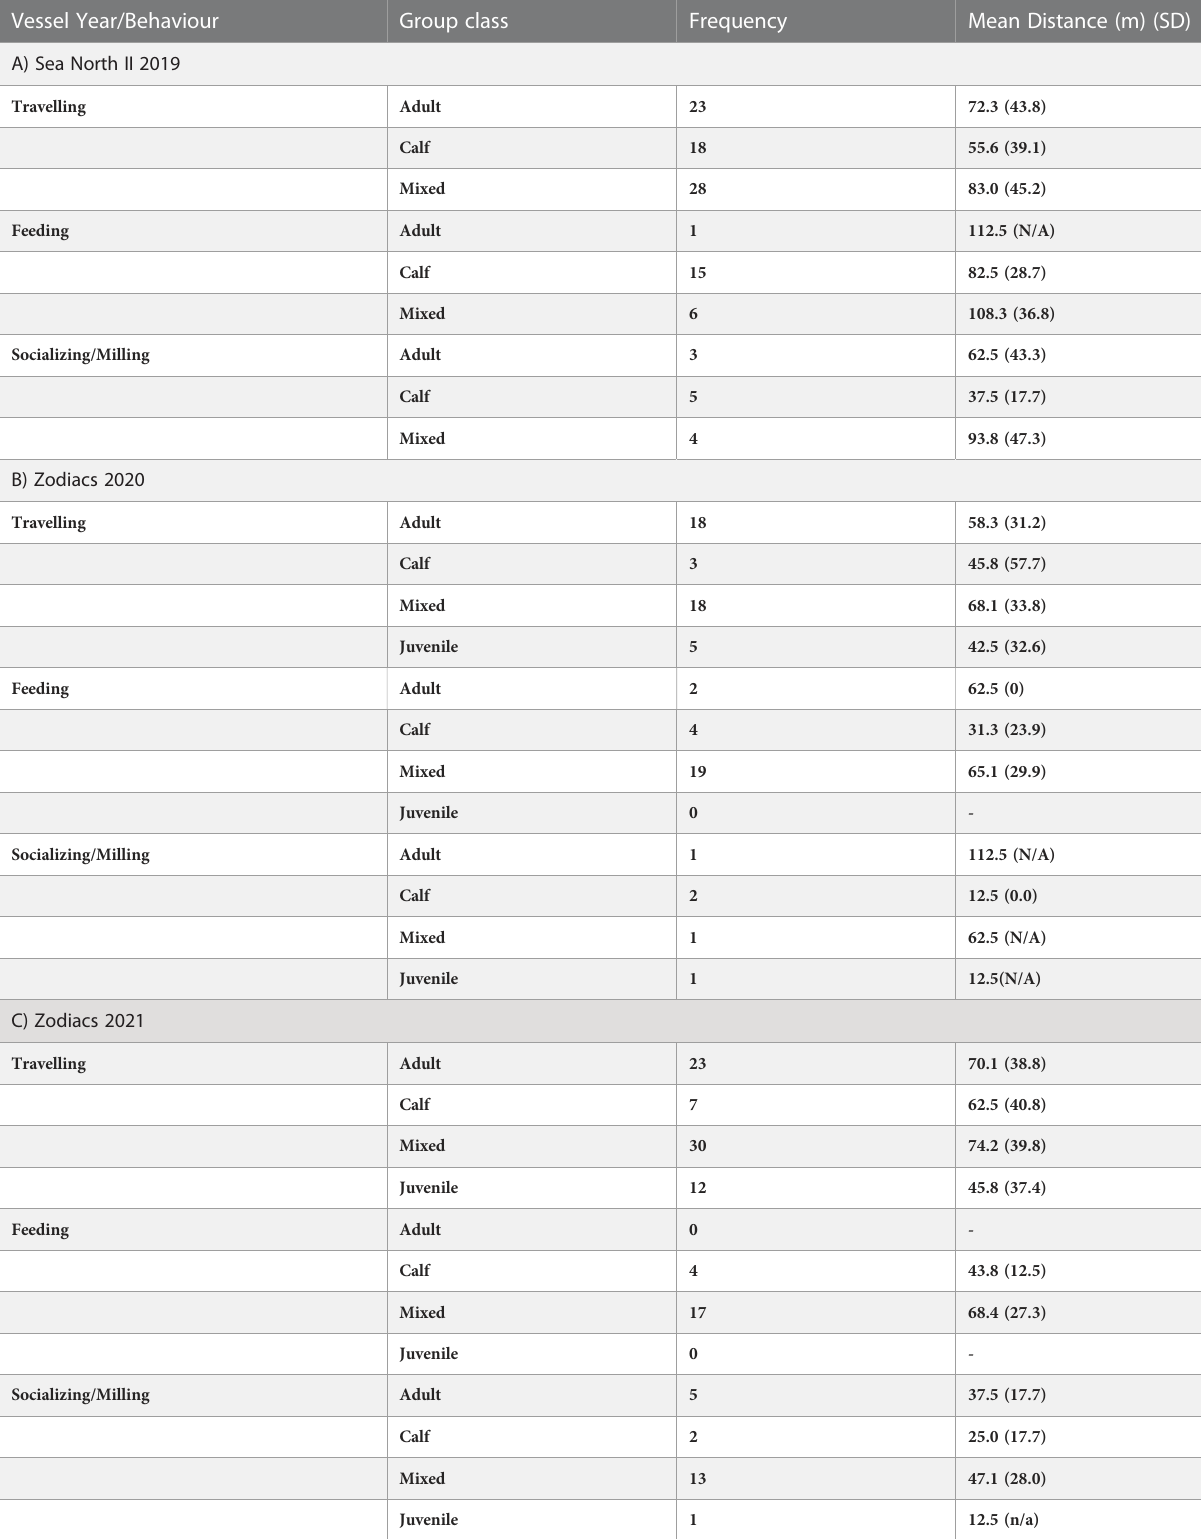
TABLE 4 Frequencies and mean distances of observed travelling, feeding and socializing/milling behaviour by age class observed from: A) Sea North II vessel in 2019; B) zodiacs in 2020; and C) zodiacs in 2021. Vessel